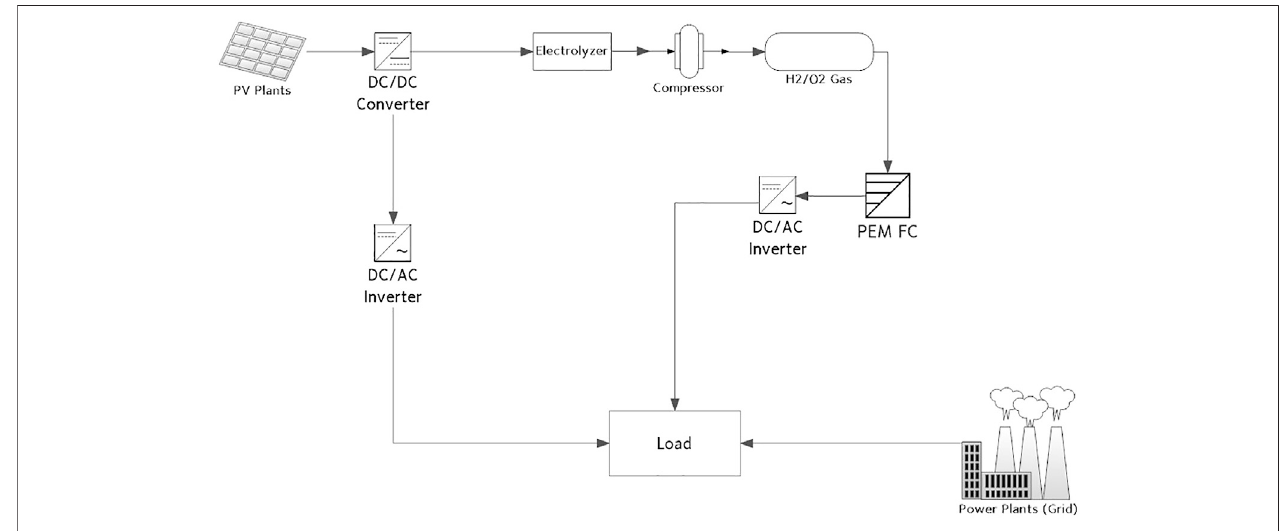
FIGURE 6 | A block diagram for PV – Electrolysis – PEM hybrid